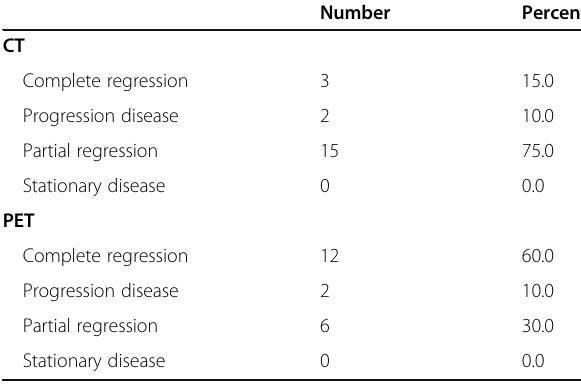
Table 5 Treatment assessment distribution of the study